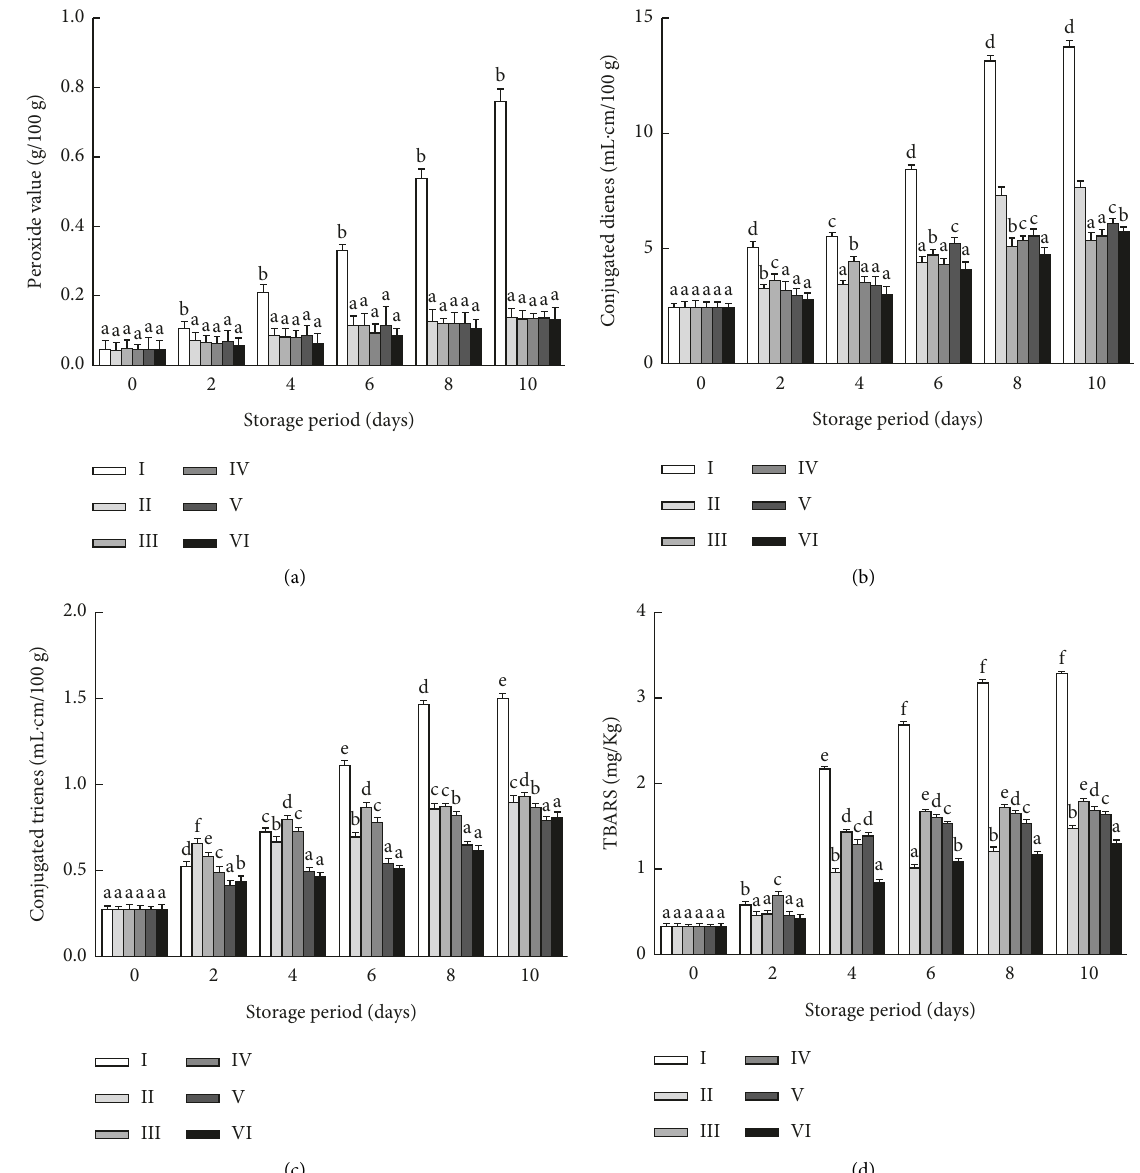
Figure 1: The changes of POV (a), CD (b), CT (c), and TBARs (d) in the peanut oil with addition of Group I II, III, IV, V, and VI antioxidants compounds during the different storage period at 65 ° C. The value was the average of the three repeated tests ± SD ( n � 3); values after different letters were considered, P < 0 . 05. POV, peroxidation value; CD, conjugated diene; CT, conjugated triene; and TBARs, thiobarbituric acid reactive